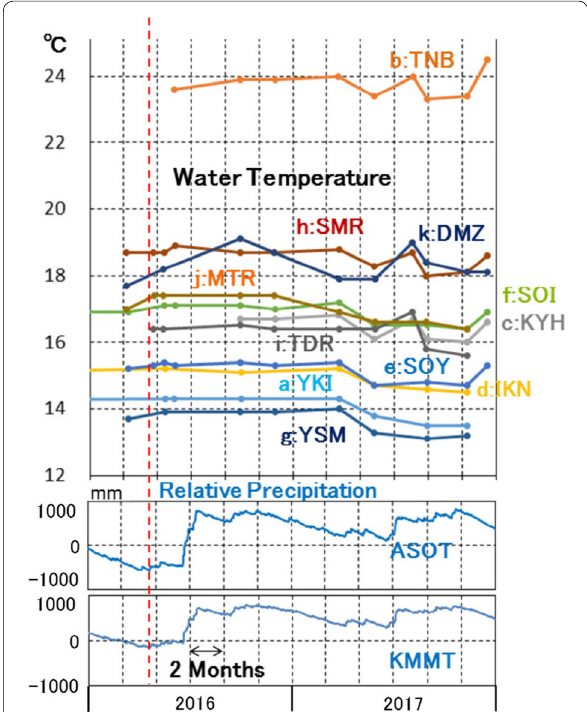
Fig. 8 Water temperature changes at the 11 observed springs and the relative precipitation at ASOT and KMMT during the period 2016– 2017. Before 2016 at a:YKI, d:IKN, and f:SOI, the temperature was, respectively, measured on February 1, 2014; September 6, 2014; and February 1, 2014. The precision of the temperature measurements is 0.1 °C. Vertical red broken line indicates the occurrence of the main shock of the 2016 Kumamoto